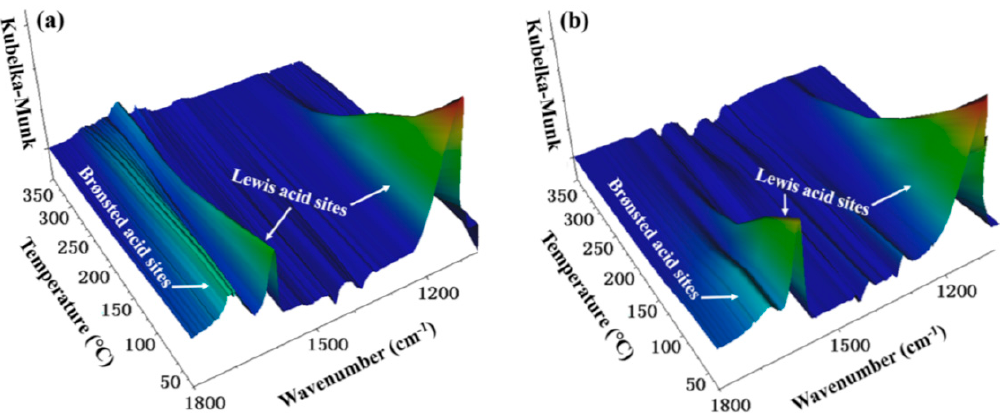
Figure 13. In situ DRIFTs of NH 3 desorption over ( a ) MnCeW/m-TiO 2 and ( b ) MnCe/m-TiO 2 catalysts as a function of temperature [87].